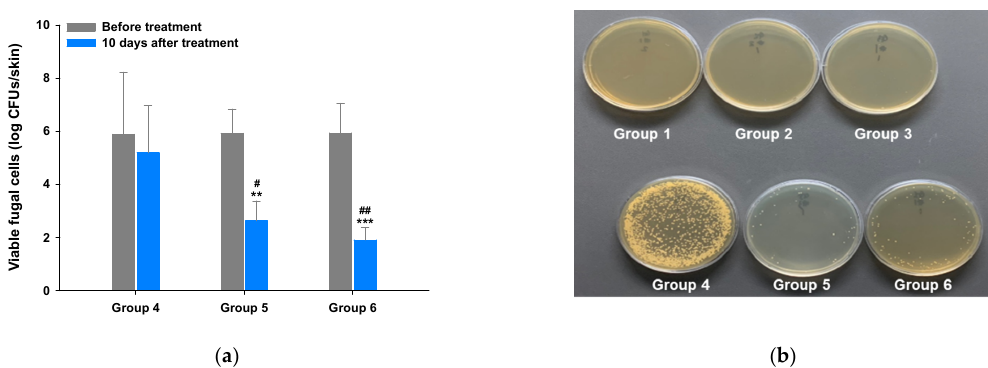
Figure 4. Mycological assay in full-thickness excisional normal, scratched, and scratched and fungal-infected mouse skins after once-daily treatment with ITZ–TF #11 (vehicle) (groups 1, 3, and 4) and ITZ–TF#11 (groups 2 and 6) based on 40 mg/kg ITZ or once-daily oral administration of 40 mg/kg ITZ (group 5) for 10 days. ( a ) Viable fungal cell counts in C. albicans -infected mouse skin lesions in groups 4, 5, and 6. Each value represents the mean ± standard deviation ( n = 5). ** p < 0.01, *** p < 0.001 compared with initial log CFUs/skin section in each group. # p < 0.05, ## p < 0.01 compared with log CFUs/skin section in group 4 after 10 days of treatment. ( b ) Representative photographs of viable fungal cells after 24 h incubation of excised normal, scratched, or scratched and fungal-infected mouse skins, following 10 days of treatment.